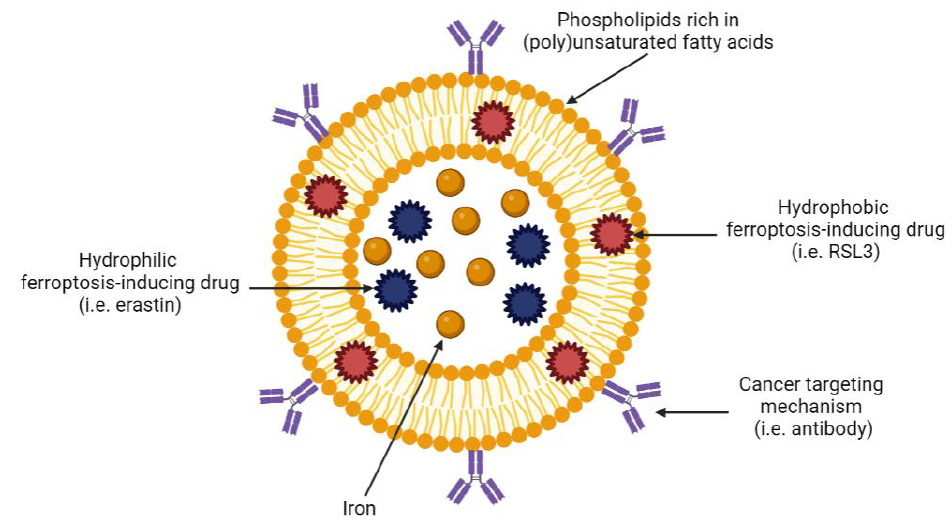
Figure 4. Example of a tumour-targeting, ferroptosis-inducing liposome. Created with BioRender.com (accessed on 27 March 2023).